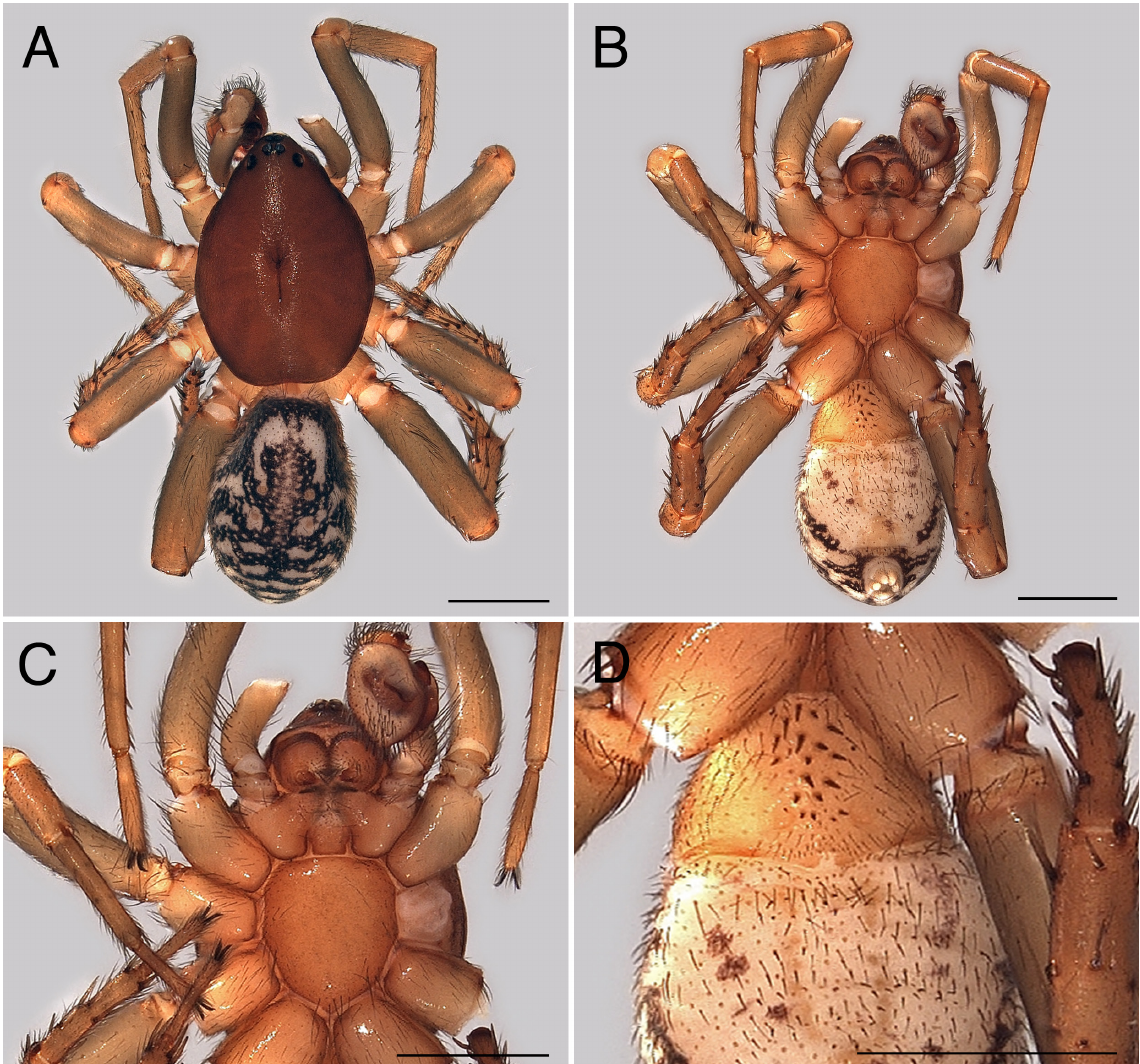
Fig. 1. Ballomma erasmus gen. et sp. nov. Holotype, ♂. A . Habitus, dorsal view. B . As preceding, ventral view. C . Prosoma, ventral view. D . Abdomen, ventral view. Scale bars: 1